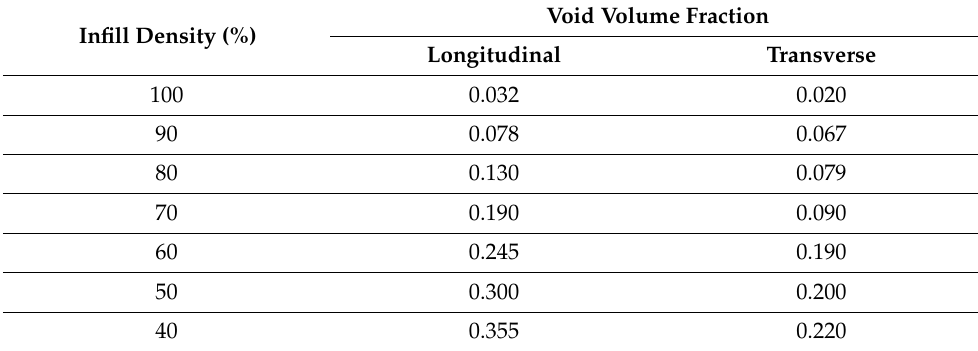
Table 4. Void volume fraction at various infill densities.